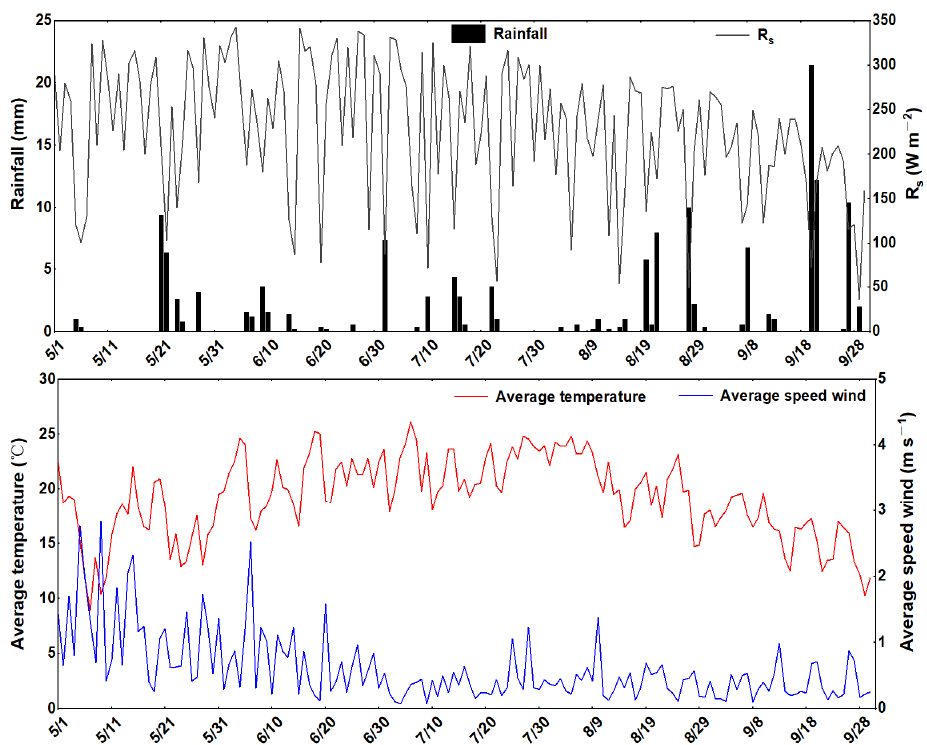
Figure 2. Daily average rainfall, solar radiation ( R s ), wind speed, and temperature during the whole growing period of spring maize in 2020.